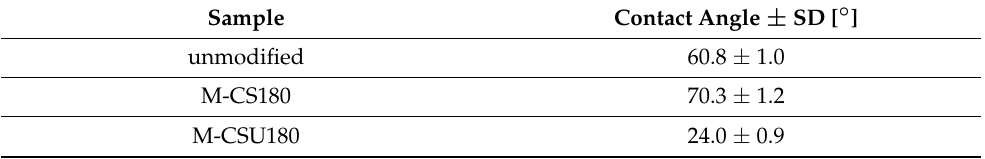
Table 4. Contact angle values for unmodified membrane and membranes modified with CNDs.